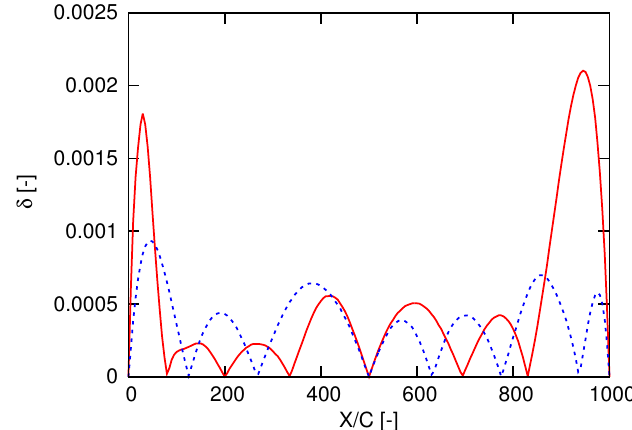
Figure 3. Curve deviation analysis of the parameterized hydrofoil, where δ denotes the normalized deviation of the Y-coordinates of the parameterized hydrofoil from that of the reference hydrofoil and X/C denotes the distance in x-direction normalized to the hydrofoil chord length. The dotted blue line represents the deviation in the suction side and the solid red line represents the deviation in the pressure side.